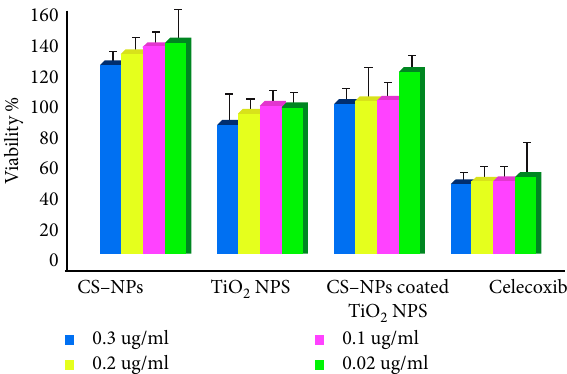
Figure 12: Cytotoxicity analysis of CS-NPs coated TiO and TiO NPs after exposure to HepG2 cell line of 2